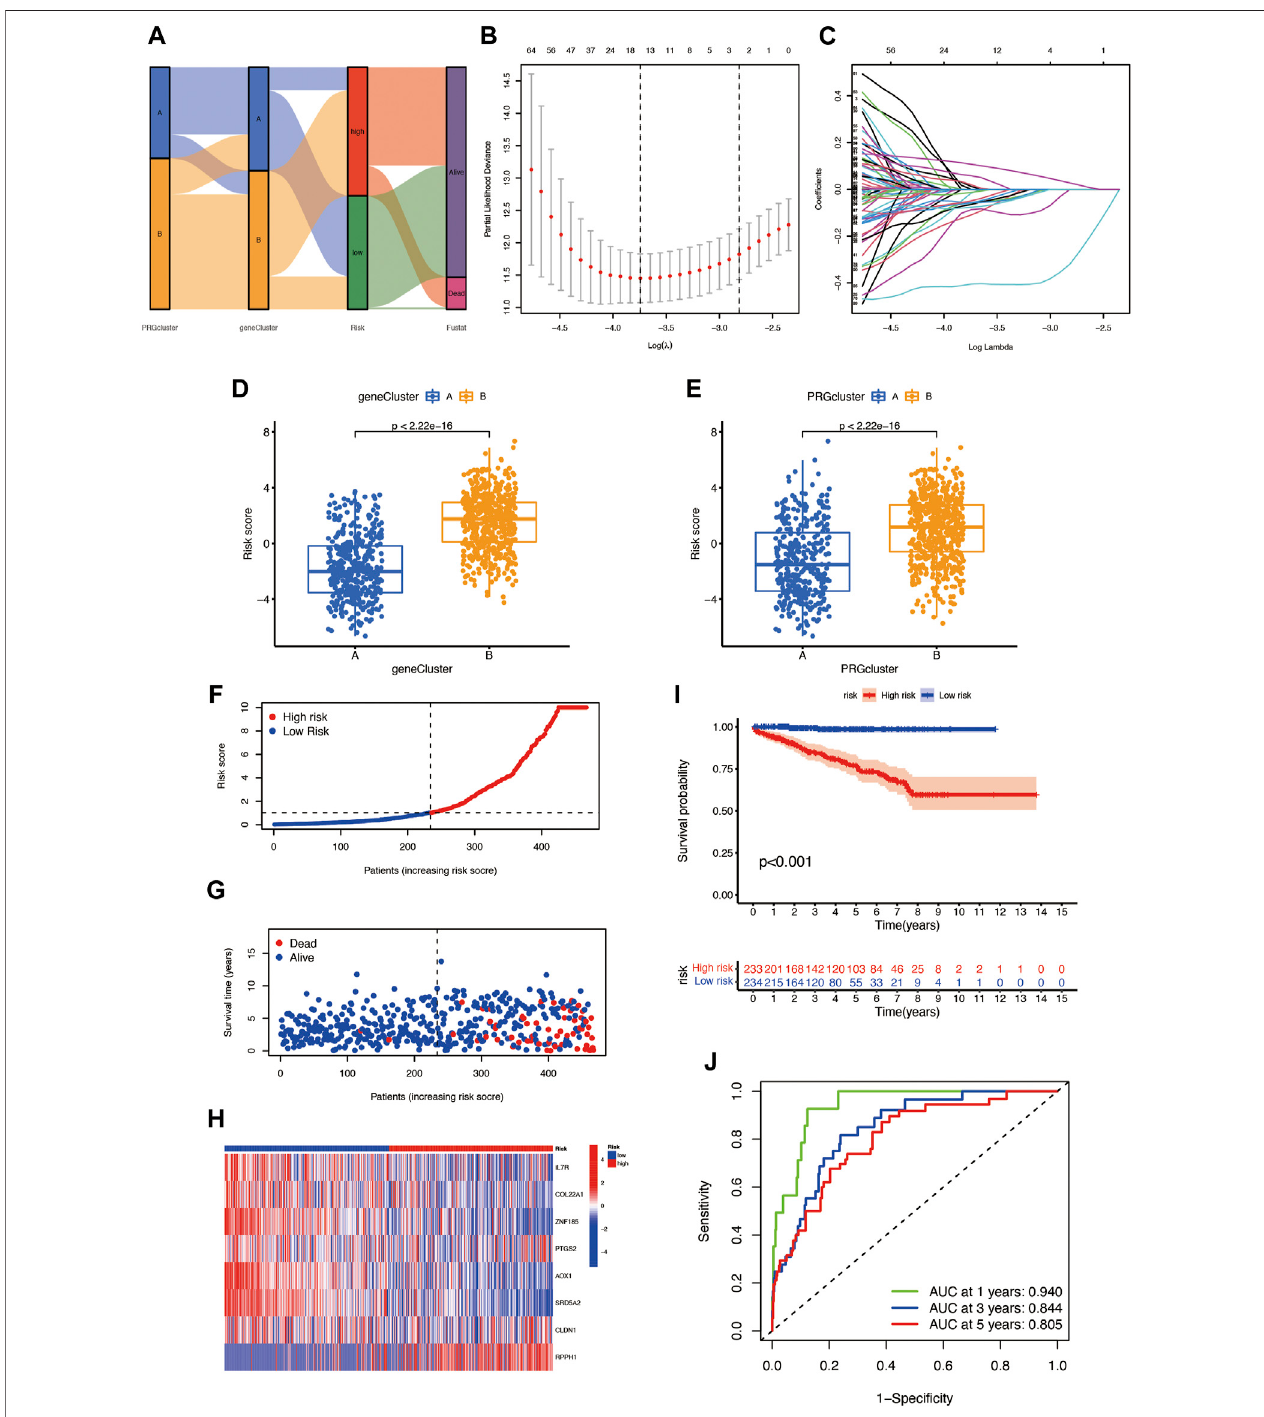
FIGURE4|(A) Distributionofpatientsindifferentgroups. (B,C) LASSO(leastabsoluteshrinkageandselectionoperator)regression. (D,E) Differentgeneclustersandsubtypes havesigni fi cantdifferencesinhigh-andlow-riskscoregroups. (F,G) Riskscoreplotsinthetrainingset. (H) Riskheatmapofthetworiskgroups. (I) TheBCReventoccurrencerateof two risk groups in the training set. (J) The 1-, 3-, and 5-year BCR rates of different risk groups in the training group; AUC values were 0.940, 0.844, and 0.805, respectively. signi fi cant meaning in different clusters ( Figure 3G ). The two and TIRAP have high expression levels in cluster B, suggesting clusters showed signi fi cant differences in the expression of that these genes may associate with poor prognosis in prostate PRGs; CHMP2A, CHMP4C, CYCS, CASP6, CASP8, GPX4, cancer ( Figure 3H ).